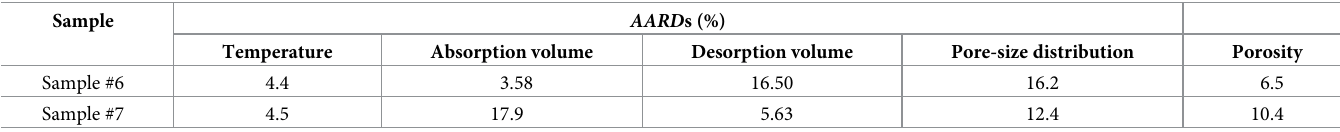
Table 2. The calculated AARDs of temperature, adsorption/desorption volume, pore-size distribution, and porosity between sample #5 and samples #6–7.